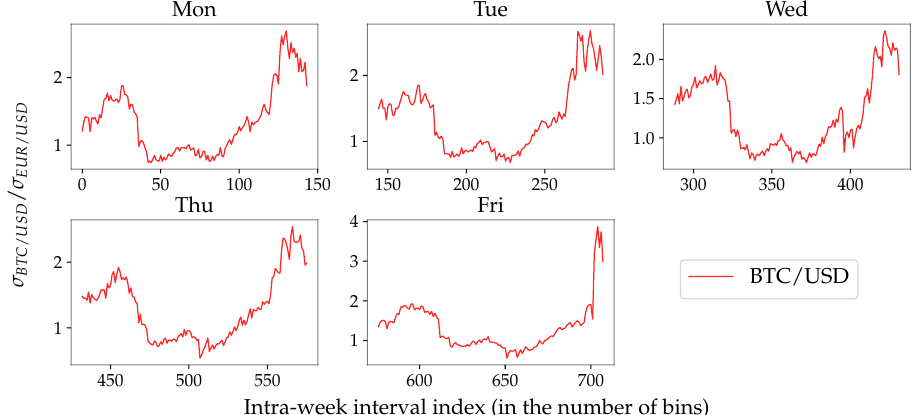
Figure A2. Daily realised volatility ratio of the given exchange rates (labelled by ***) and EUR/USD. The volatility is computed according to the “traditional” approach (Equation (20)).